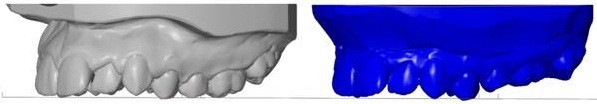
Case 1: aligned 3D scans of pre- and post-intrusion plaster casts.